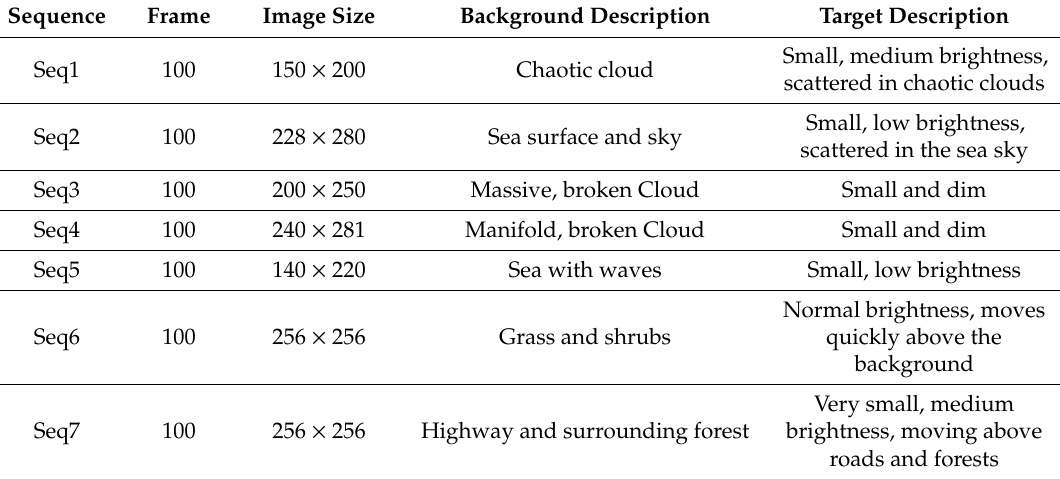
Table 1. Description of our